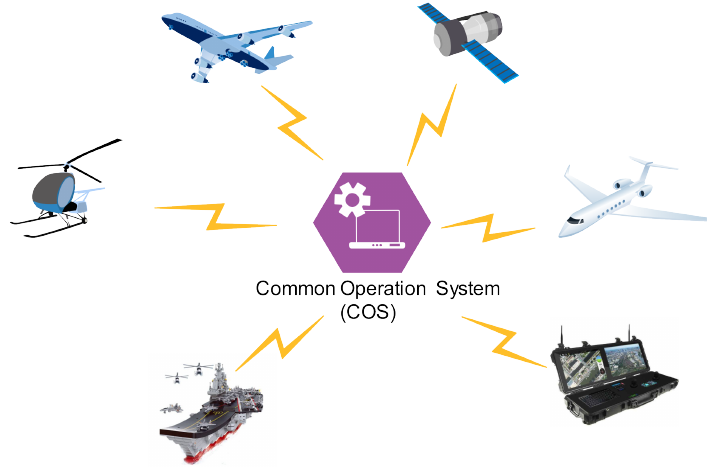
Figure 8. Common operation